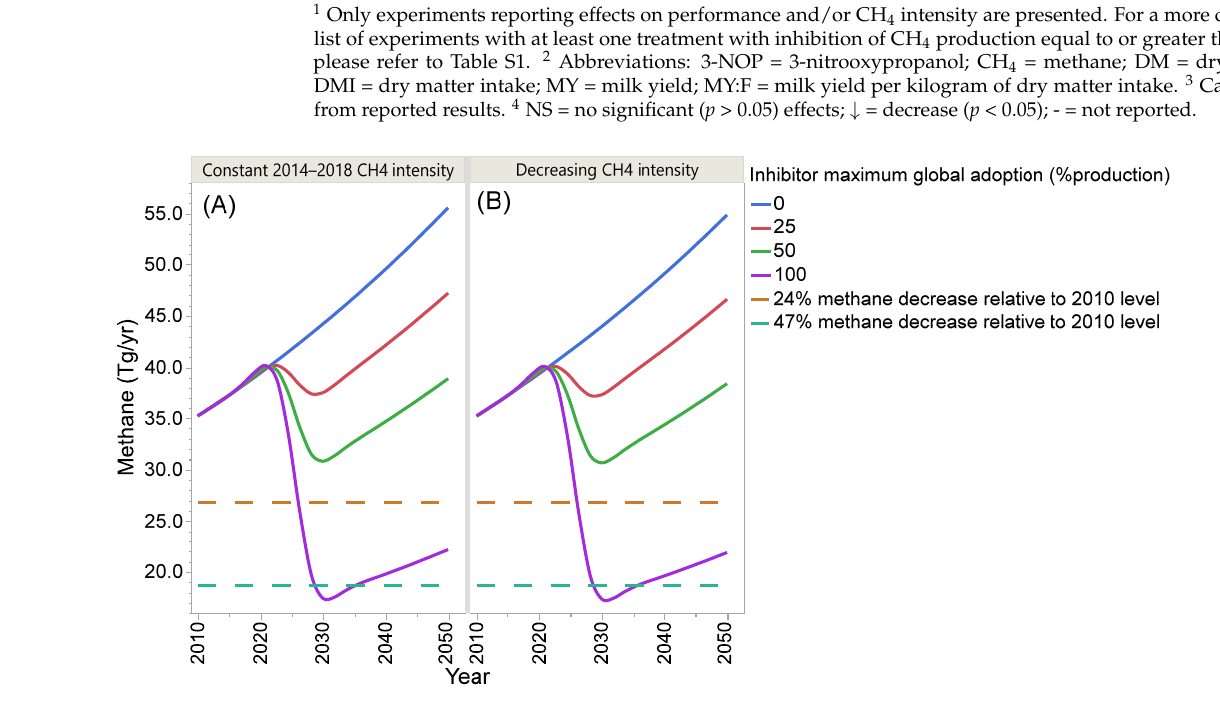
Figure 5. Predicted evolution of enteric methane (CH 4 ) emissions from global beef production between 2010 and 2050 considering ( A ) constant CH 4 intensity and ( B ) declining CH 4 intensity according to Table 1. Adoption of feed additive inhibitors of methanogenesis decreasing CH 4 intensity by 60% is simulated to occur at 0, 25, 50, or 100% of global beef production. Decreases in enteric CH 4 emissions of 24 and 47% relative to 2010 required to maintain a global temperature increase within 1.5 °C according to different socioeconomic scenarios and climate models [15] are shown in dashed lines.